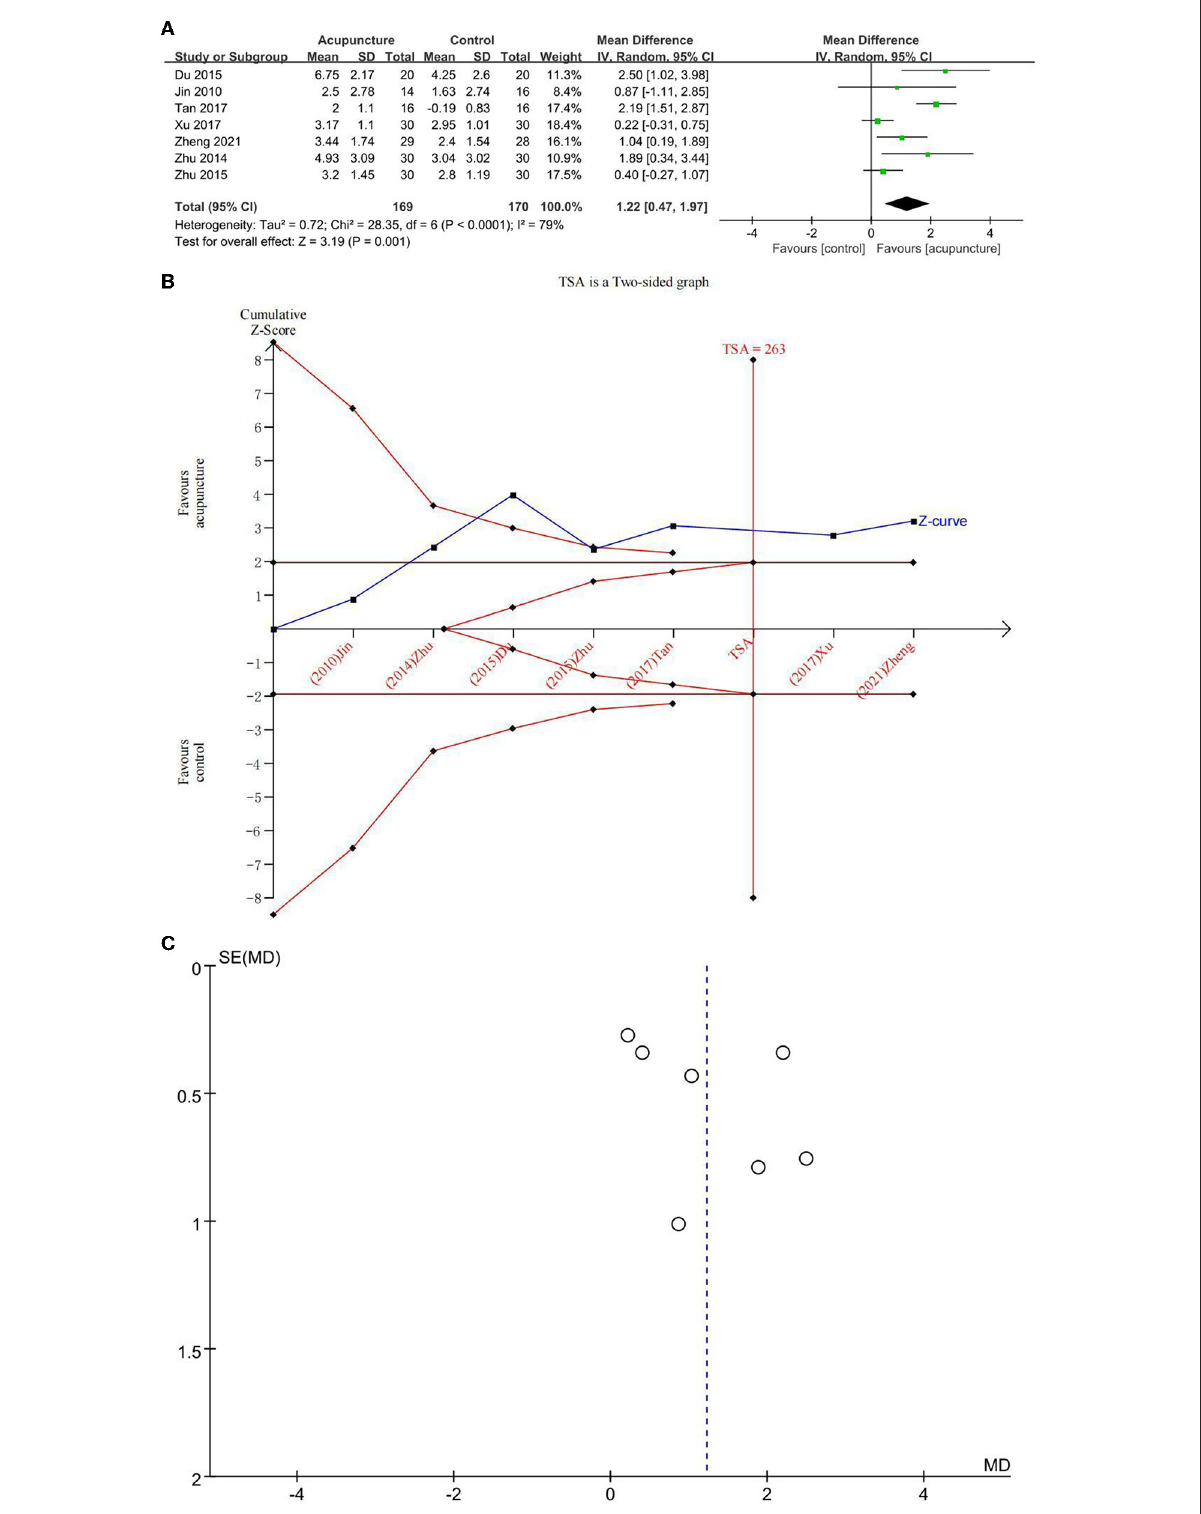
FIGURE4 (A) Forest plot of improvement of Montreal Cognitive Assessment Scale (MoCA); (B) trial sequential analysis of improvement of MoCA; and (C) funnel plot of improvement of